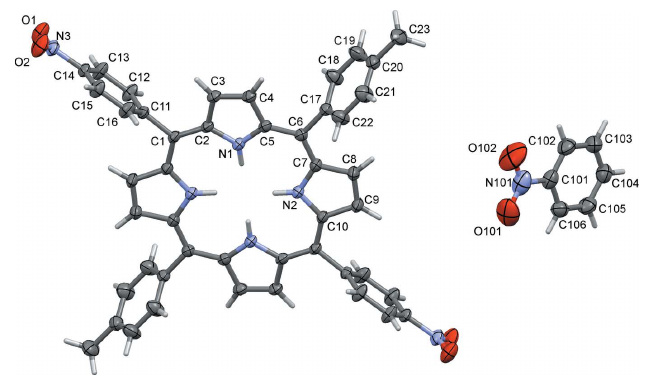
Figure 1 The molecular structure of the title compound, with the atom labelling. Displacement ellipsoids are drawn at the 50% probability level. Unlabelled atoms are related to labelled atoms by inversion symmetry (symmetry operation: (cid:5) x , 2 (cid:5) y , (cid:5) z ), and only one solvent molecule is